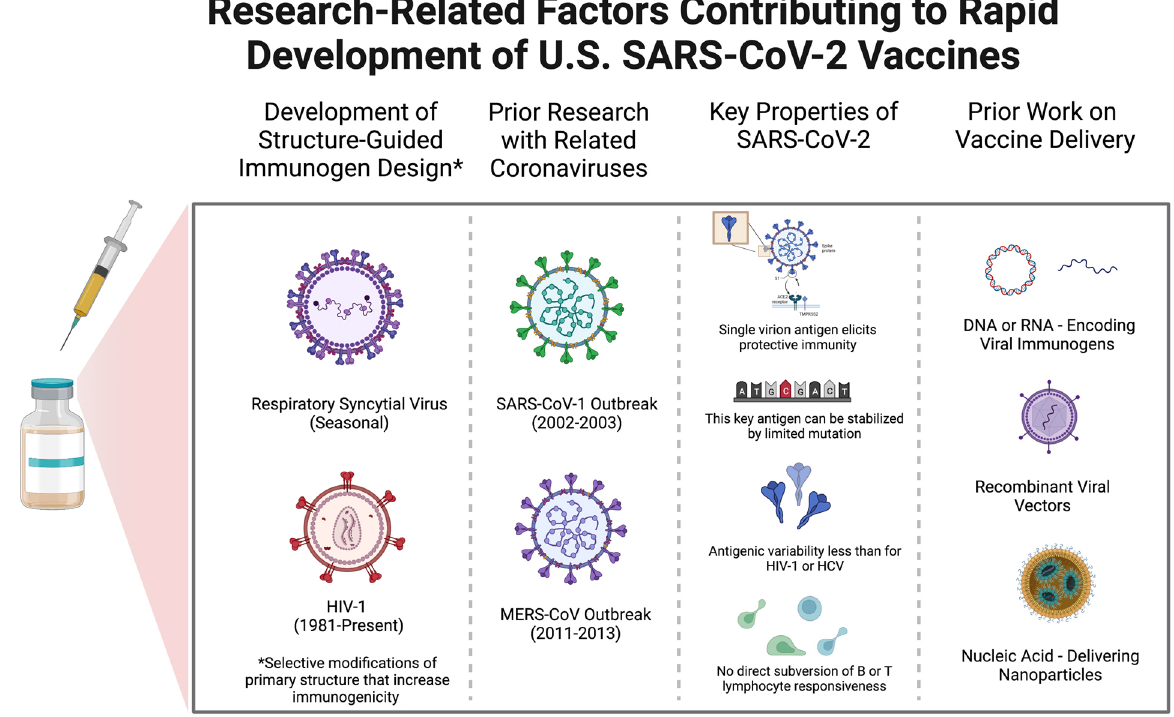
Figure 1. Scientific factors contributing to the relatively rapid development of safe and effective SARS-CoV-2 vaccines. The schematic diagrams from left to right allude to the roles of prior research on structure-guided vaccine design, previous work focused on the immunologic attributes of coronaviruses similar in key respects to SARS-CoV-2, critical features of SARS-CoV-2 itself, and past efforts to develop the use of nucleic acids that encode immunogens to be produced by recipient cells as well as viral vectors and nanoparticles for vaccine delivery to host